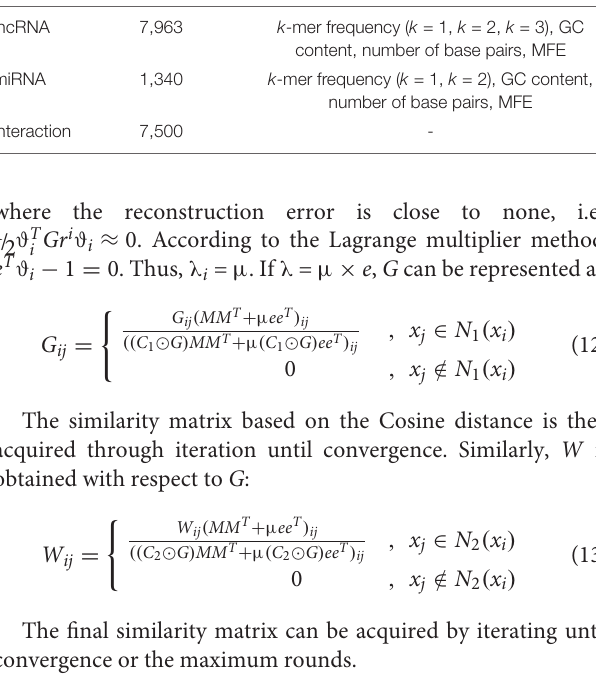
TABLE 1 | Dataset composition.